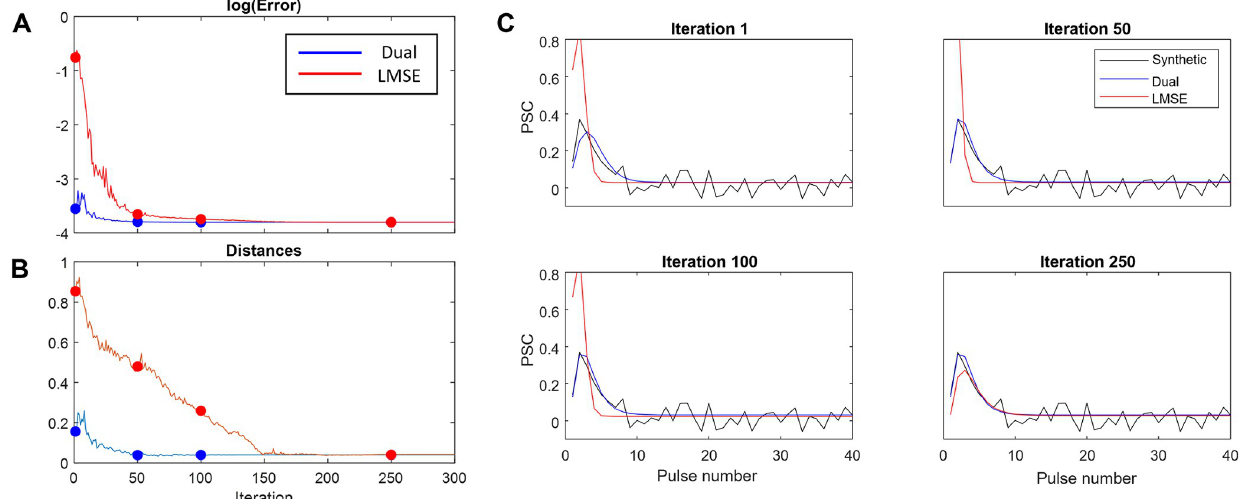
Fig 4. Comparison between accuracy and speed of convergence for the dual optimization approach and the conventional LMSE approach. (A) The log MSE of the model output at each iteration of the non-derivative optimization ( B) The average distance (norm 2 of [ f , U , F , D ] vector) between the estimated parameter set at each iteration and the true parameter set ( C) The peak PSC series generated by the estimated parameters at some iterations of the model.